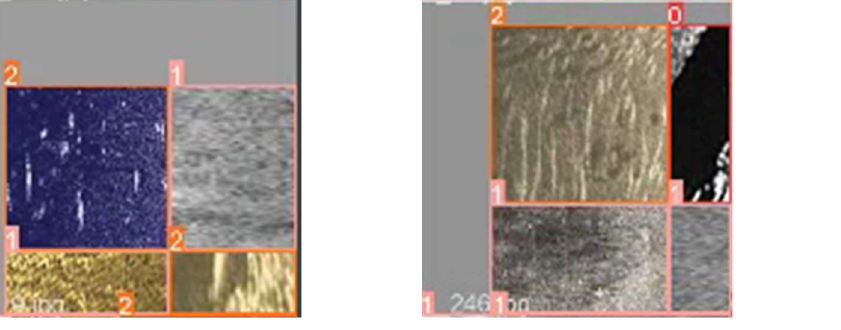
Figure 15. Some example target detection results of the proposed ODP+YOLO V3 + SPP method for the three sets of side scan sonar datasets, including Sunken Ship, Fish Flock, Seafloor Topography: label 0 refers to Sunken Ship; label 1 refers to Fish Flock; and label 2 refers to Seafloor Topography. Table 4. The evaluation indicators for three kinds of side scan sonar datasets based on the YOLO V3 + SPP with online datasets preprocessing method.